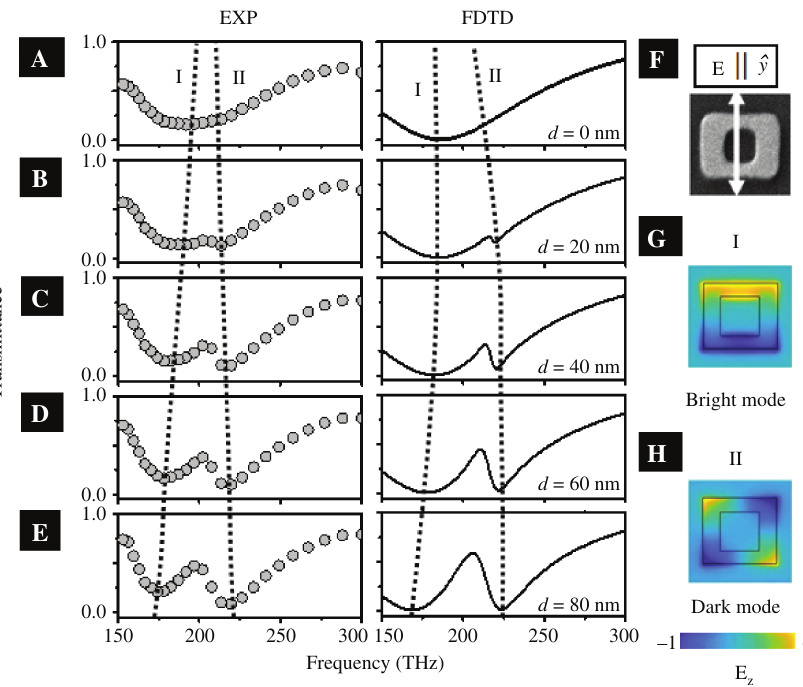
Figure 3: Experimental and numerical results of coupled plasmonic systems for y -polarization. (A–E) Measured (open symbols in the left panels) and simulated (solid black curves in the right panels) transmission spectra of samples ) patterns of the symmetric nanostructure at with different values of d , with (F) y -polarized incident light. (G, H) The simulated Re(E z frequencies corresponding to the dipole mode (labeled as the mode “I”) and the quadrupole mode (labeled as the mode “II”) for y -polarization. Dotted lines represent the resonant frequencies of the bright and dark modes with different values of d for y